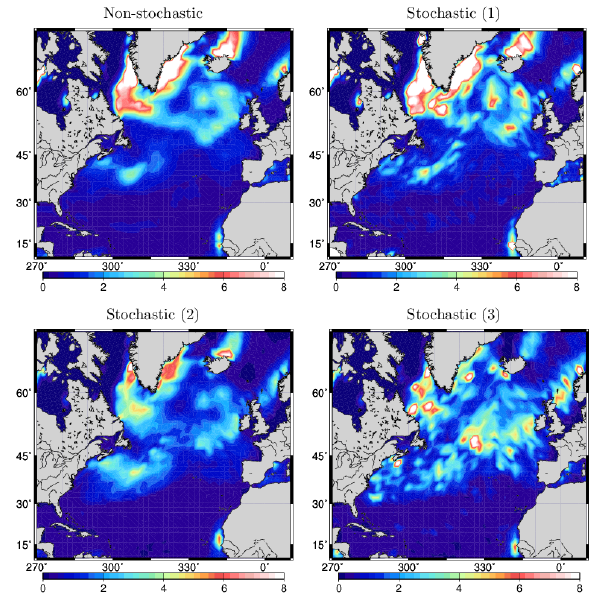
Figure 3. Surface phytoplankton concentration (in mmolNm − 3 ) for 15 June as obtained with various stochastic parameterizations of uncertainties in the ecosystem model: no stochastic parameteri- zation (top left panel), stochastic simulation of unresolved diversity (top right panel), stochastic simulation of unresolved scales (bot- tom left panel), and stochastic simulation of unresolved diversity and unresolved scales (bottom right panel).